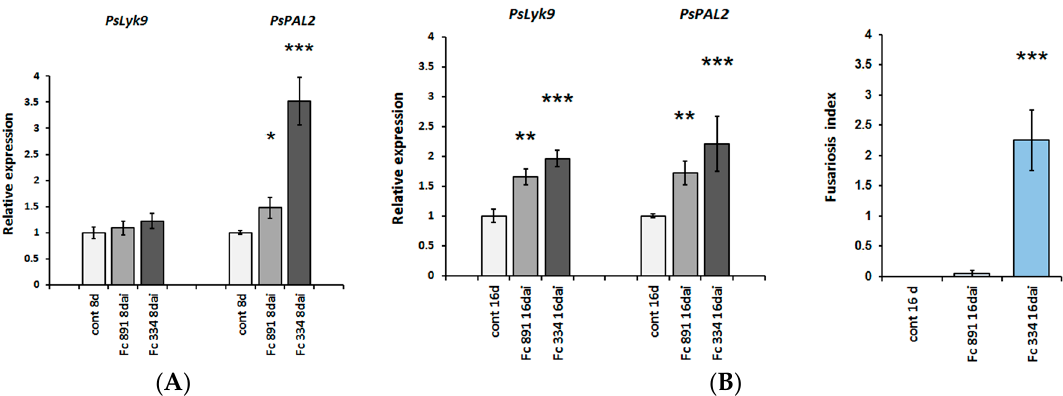
Figure 4. PsLyk9 , PsPAL2 gene expression in pea roots on days 8 ( A ) and 16 (( B ), left ) after infection with phytopathogenic fungi F. culmorum . Weakly pathogenic Fc 891 and highly pathogenic Fc 334 strains were used for infection. As a control, non-infected plants were used. Disease symptoms were evaluated in points on day 16 (( B ), right ), when the signs of disease began to appear on pea plants. No visible signs of disease were found on day 8 after infection. Asterisks indicate statistically significant differences compared with control non-infected plants: *** p < 0.001, ** p < 0.01, * p < 0.05.